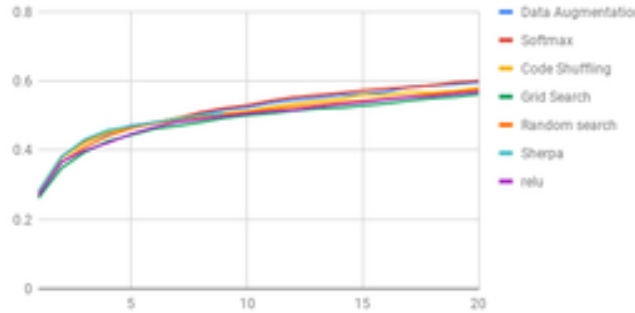
Table 1. Activation function optimisation of Capsnets on CIFAR- 10 dataset in terms of Accuracy